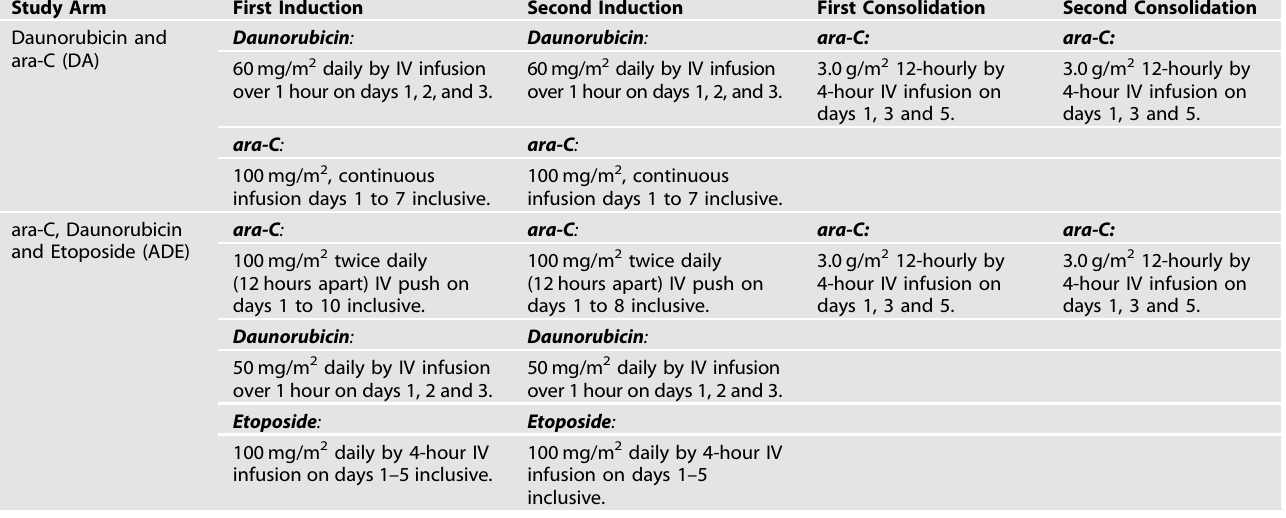
Table 1. Chemotherapy doses and schedule for the study regimens. Study